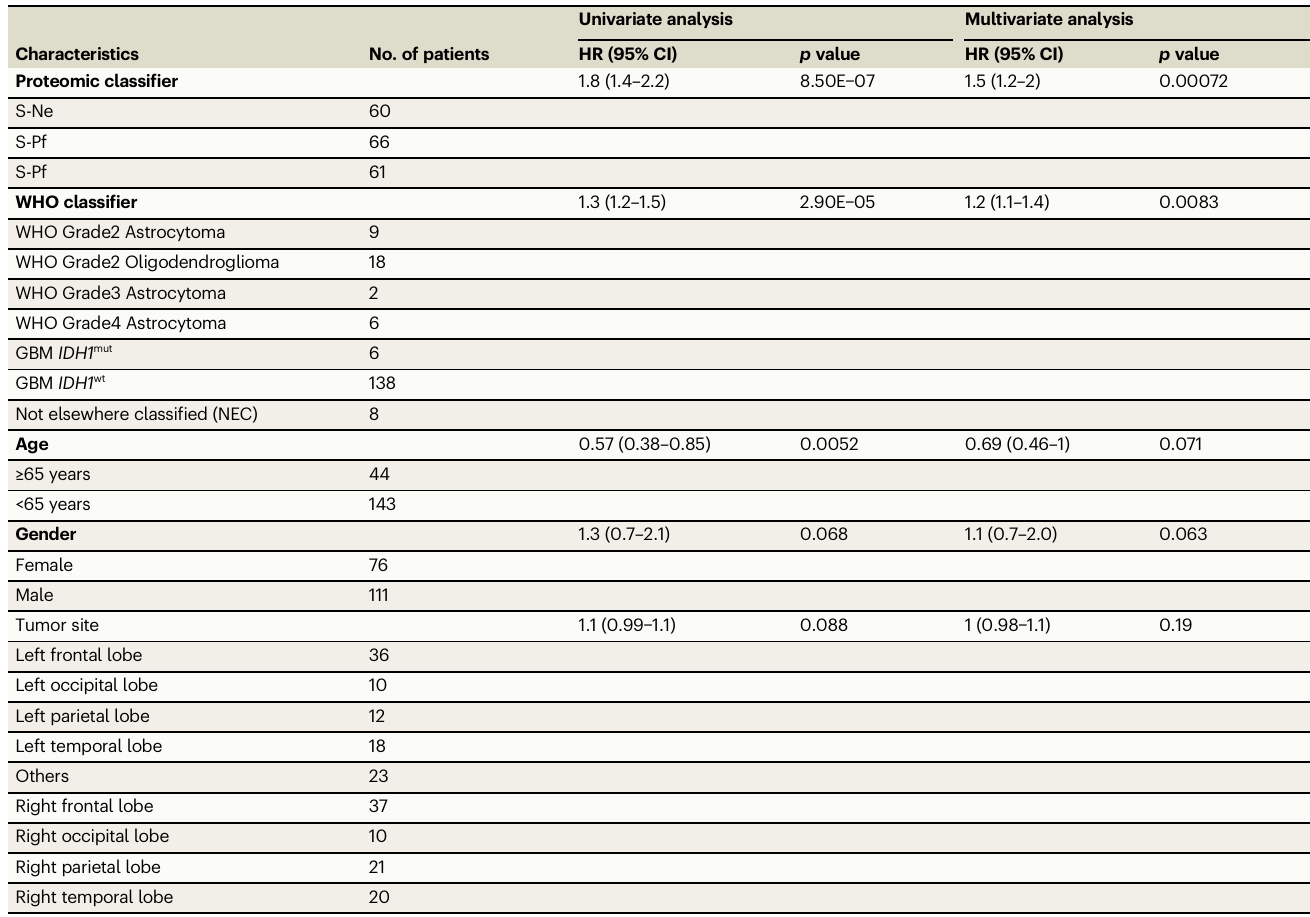
Table 1 | Univariate and multivariate analysis of overall survival in 187 patients